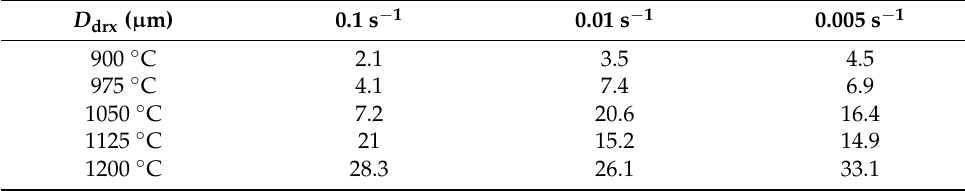
Table 6. Grain size of Cr8 alloy steel under different